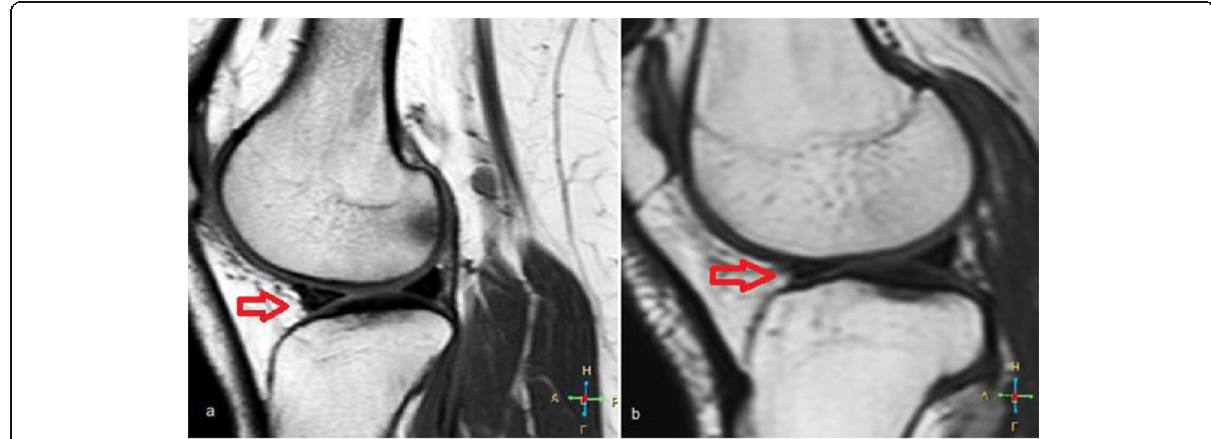
Fig. 11 a , b MRI images for torn anterior horn of the medial meniscus. a Sagittal PD and b sagittal T1-weighted images demonstrated a branching band of abnormal signal within the anterior horn of the lateral meniscus that was seen reaching to both articular surfaces (open red arrows)